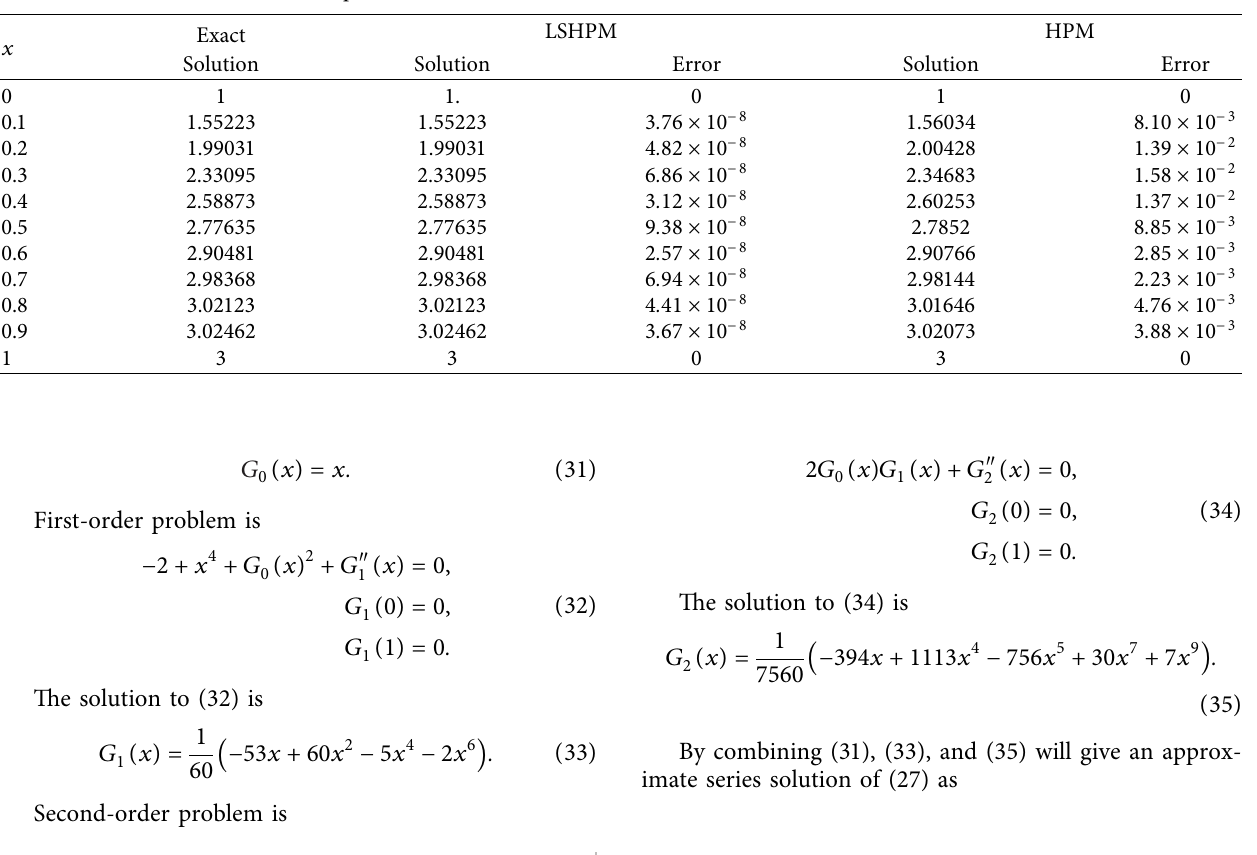
Table 1: Comparison of third-order absolute error of LSHPM with HPM in Problem